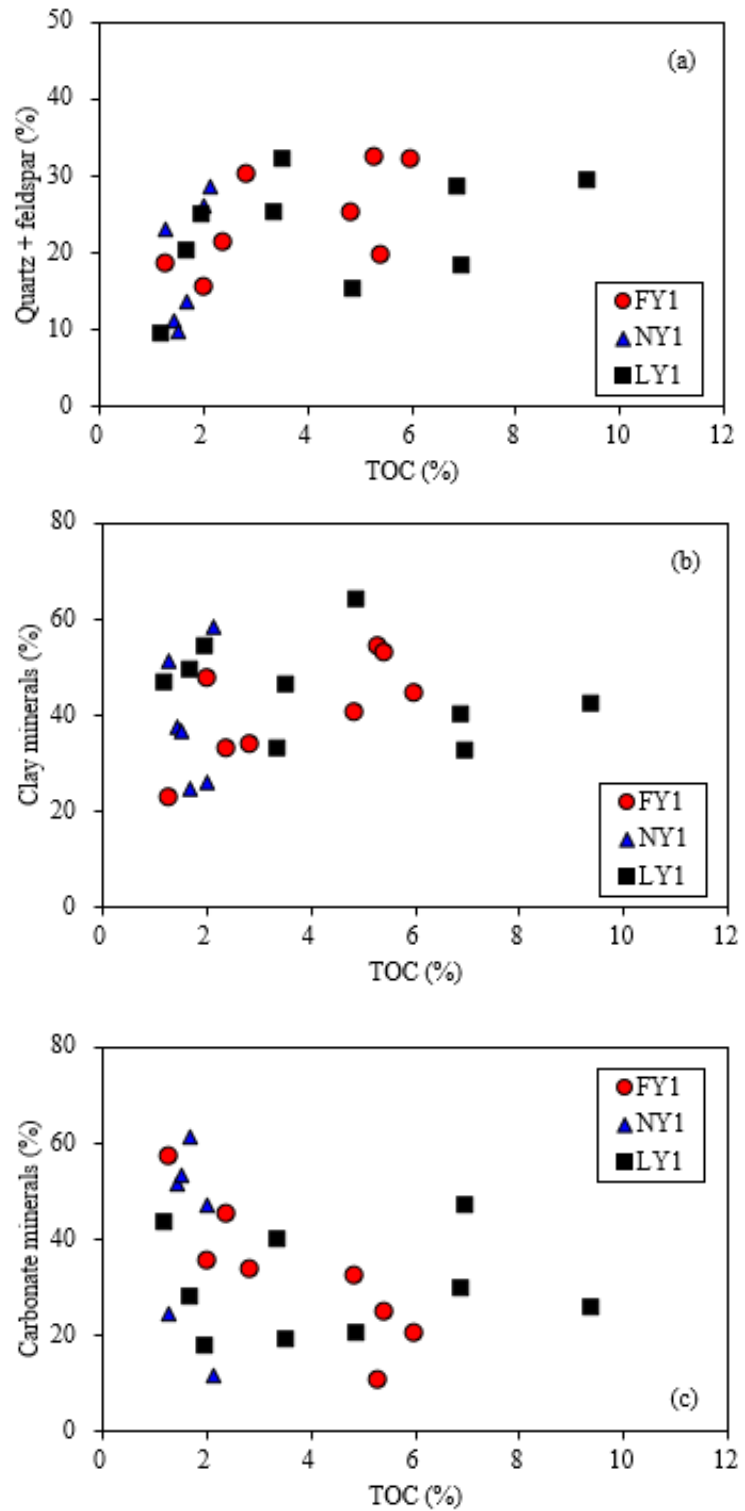
Figure 6. Plots showing relationships between TOC and quartz + feldspar ( a ), clay minerals ( b ) and carbonate minerals ( c ) of the studied samples.